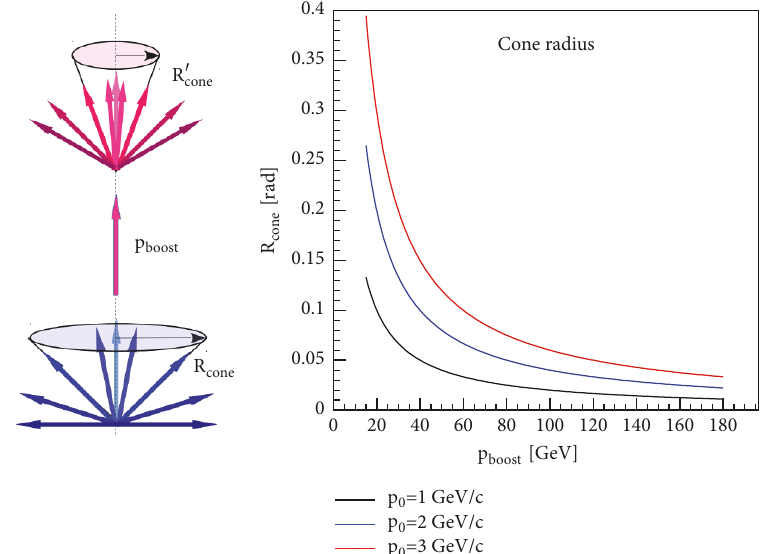
Figure 8: Left: cartoon illustrating the narrowing of a jet cone by Lorentz-boost. Right: cone radii according to the simplistic boosted-cone model for different 𝑝 0 assumptions (see text for